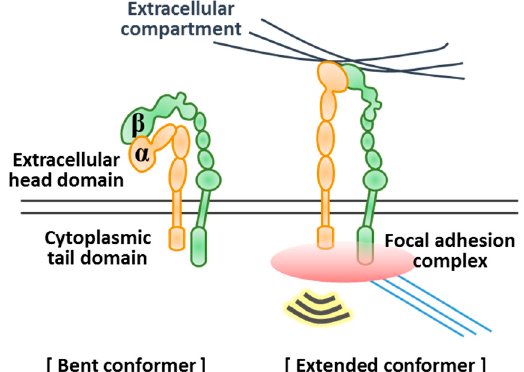
Figure 4. Conformational rearrangement of integrin upon attachment to substrate [79–81]. Integrin receptor proteins work as αβ heterodimers. When attaching to substrate, integrins undergo conformational rearrangements from bent conformation with low affinity for ligand to extended conformation with high affinity for ligand. This integrin binding to substrates induces signal transduction and provides physical connections between extracellular and intracellular regions through focal adhesion complex formation. Table 5. Integrin subunit pairing and binding ligands [76,77,82–84] . VCAM: vascular cell adhesion molecule, ICAM: intercellular adhesion molecule, LAP: latency-associated peptide, TGF- β : transforming growth factor beta, vWF: von Willebrand factor.